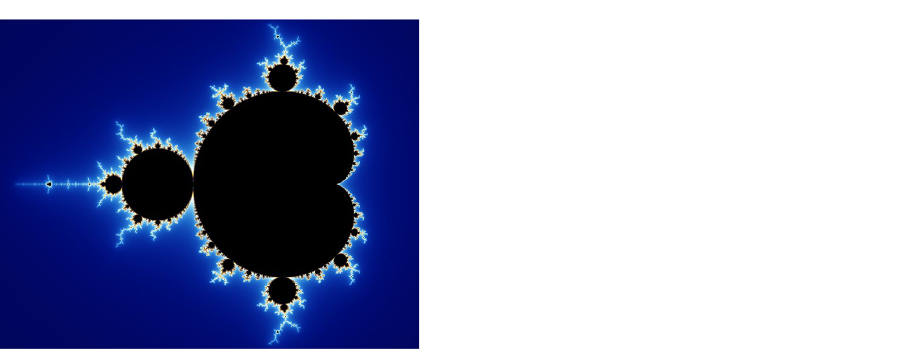
Figure 1. The Mandelbrot